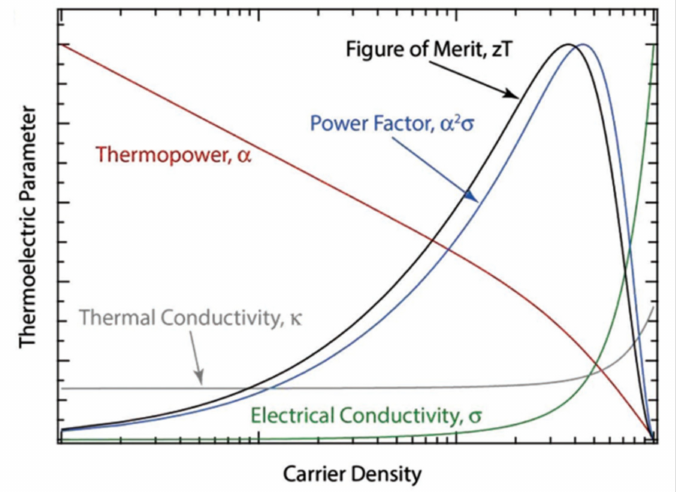
Figure 4. The interdependence of parameters of thermoelectric materials [160]; copyright Wiley- VCH